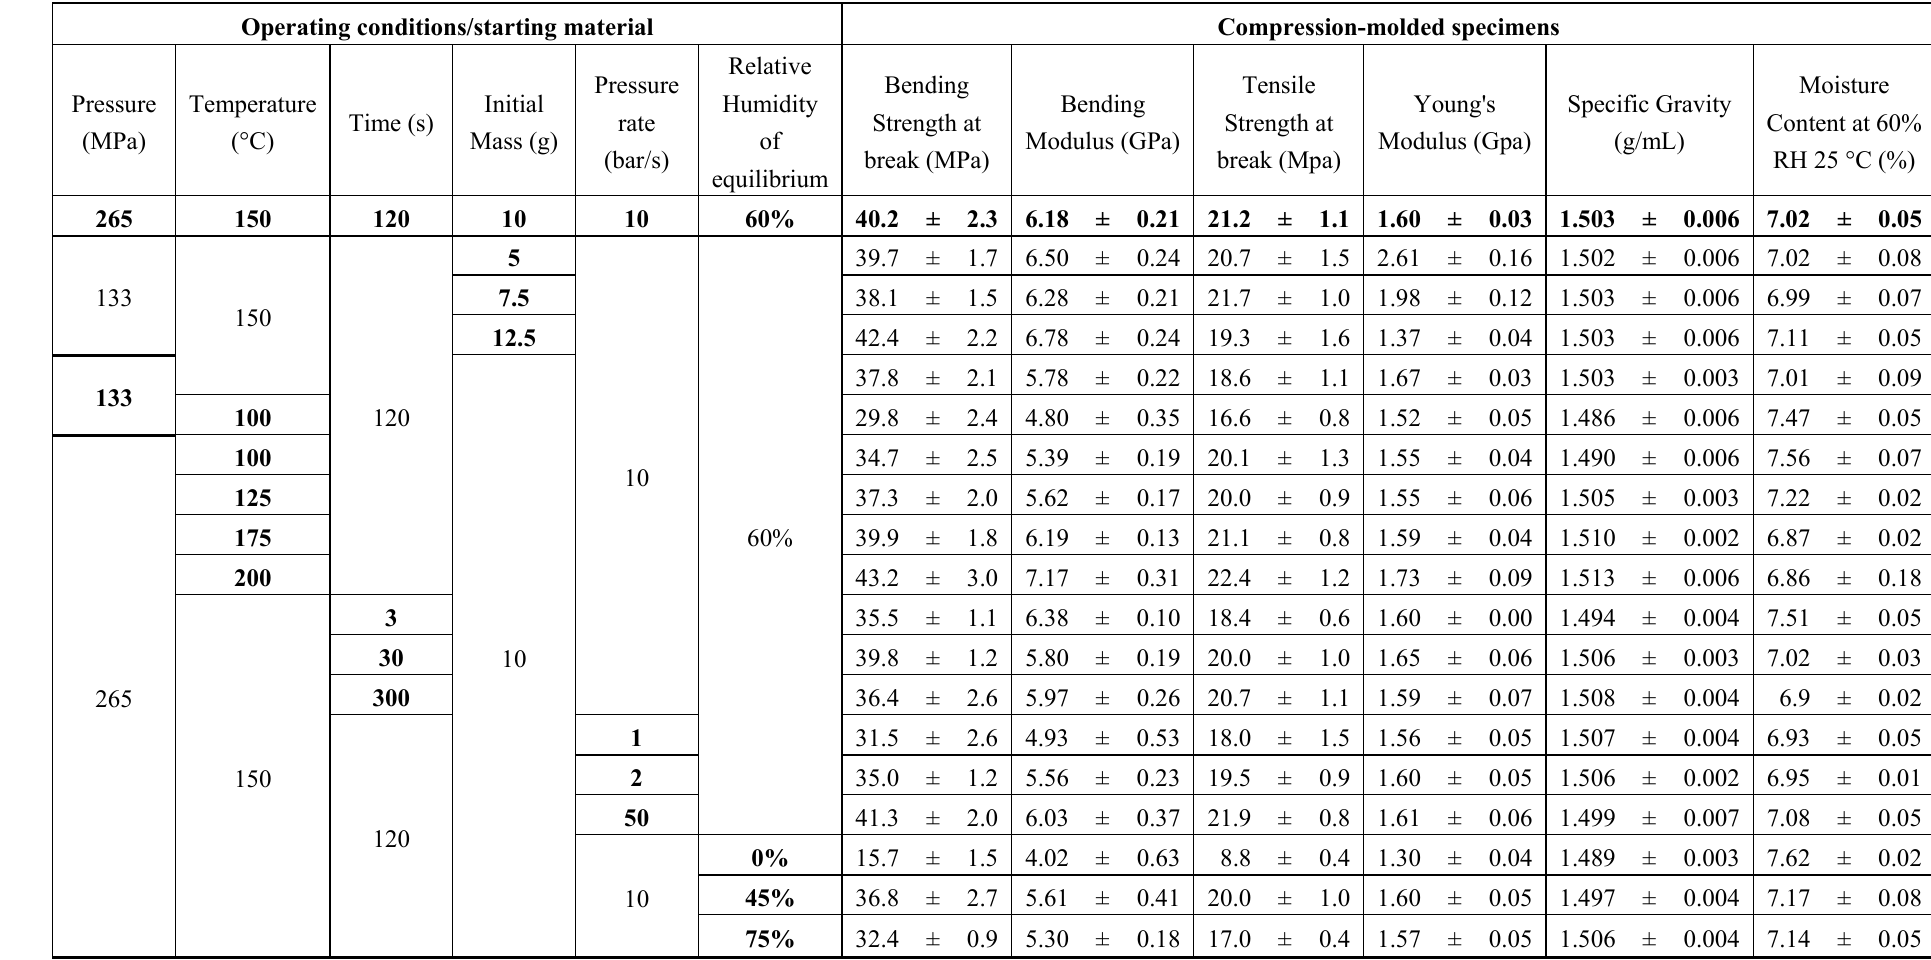
Table 1. Summary of operating conditions and measurements made on α -cellulose compressed specimens. Values are represented with their means ± confident interval (95%). Seven to 15 replicates for the mechanical properties, 6 for determination of specific gravity and moisture content at 60% relative humidity and 25